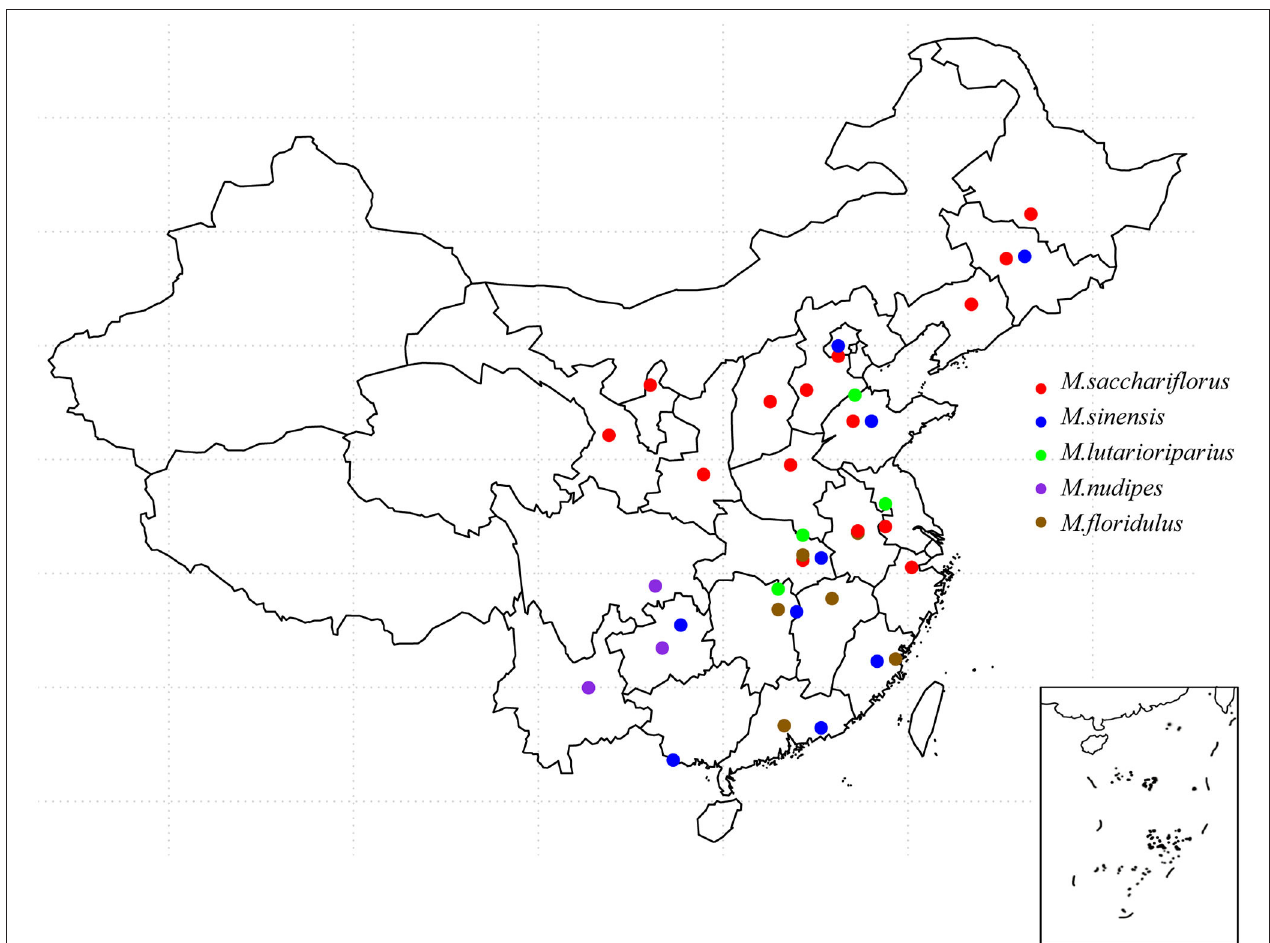
FIGURE 1 | Distribution of Miscanthus species in China. The picture on the bottom right shows the South China Sea Islands.